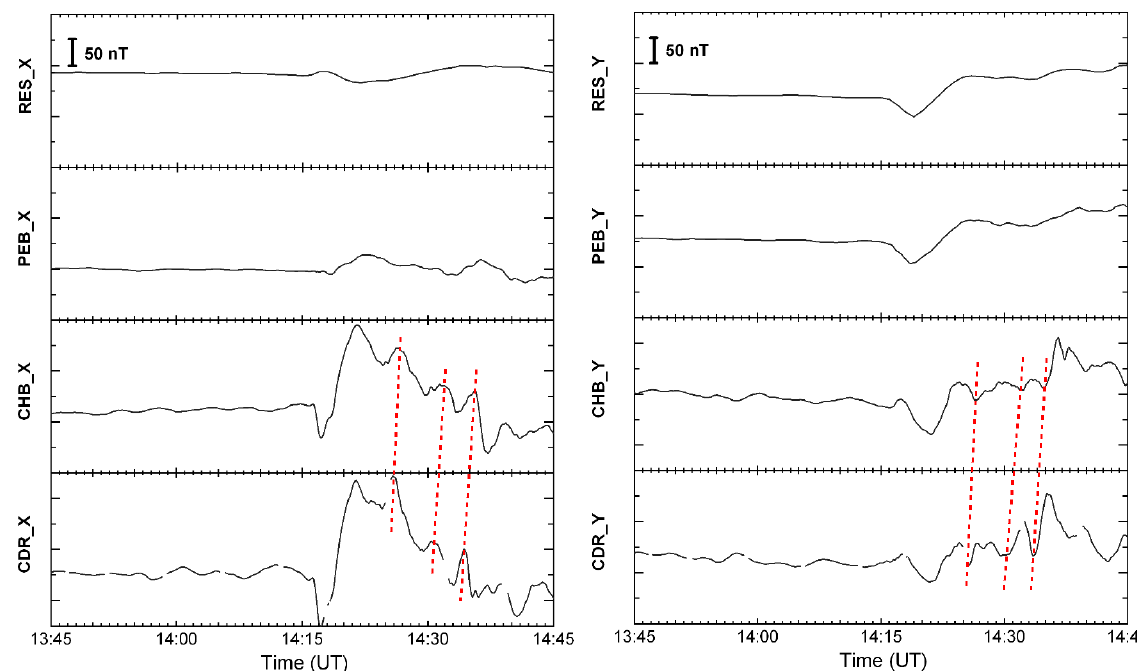
Fig. 4. High latitude magnetograms from the MACCS chain, above Northern Canada (morning MLT), on 6 January 1998 between 13:45 and 14:45UT. The left side of the figure shows the X (North-South) component, the right side displays the Y component (East-West). The stations are displayed in decreasing order of magnetic latitude from the northernmost, on top (RES – Resolute Bay, ∼ 83 ◦ MLAT), to the southernmost, on bottom (CDR – Cape Dorset, ∼ 74 . 5 ◦ MLAT). The red dashed lines evidence the evolution of magnetic transients moving from CDR to